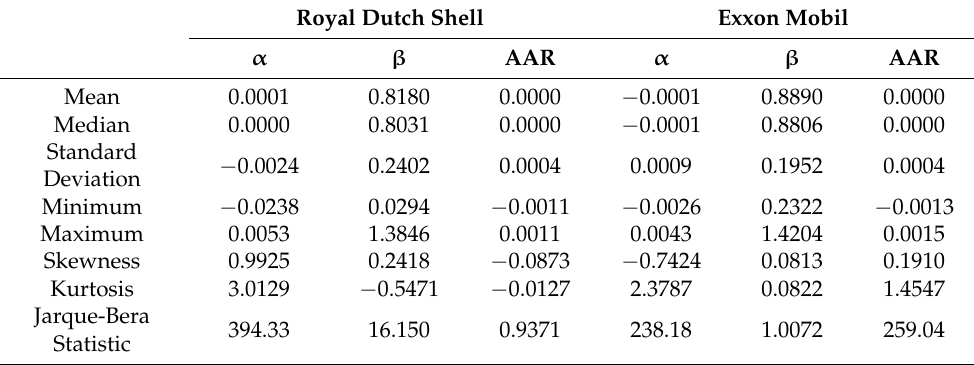
Table A1. Descriptive statistics of the alpha, beta and average market and average abnormal returns regarding the induced seismicity in the US and the Netherlands in the estimation window (day -100 to day -1), ( df =